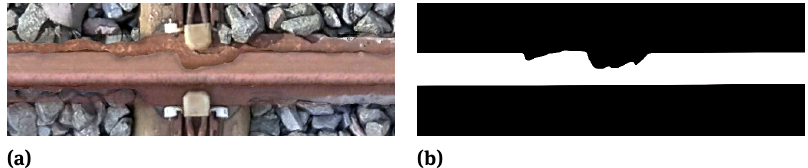
Figure 4: Example of a learning pair a) An image fed to the network input, b) A corresponding image after segmentation, which should be generated by the network.